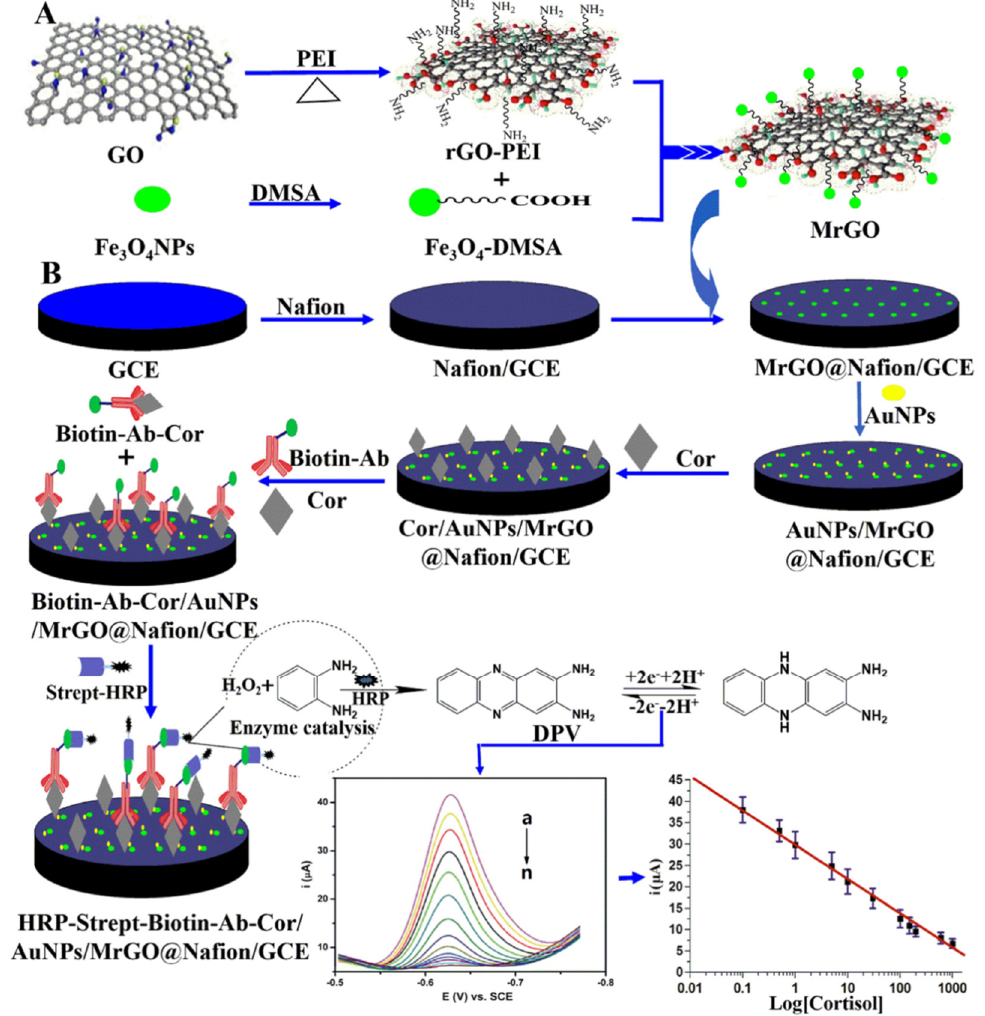
Figure 10. Scheme of the construction of the electrochemical cortisol immunosensor; ( A ) GO func- tionalization; ( B ) surface functionalization and detection mechanism (reproduced with permission from [67]. Copyright 2017 Elsevier).